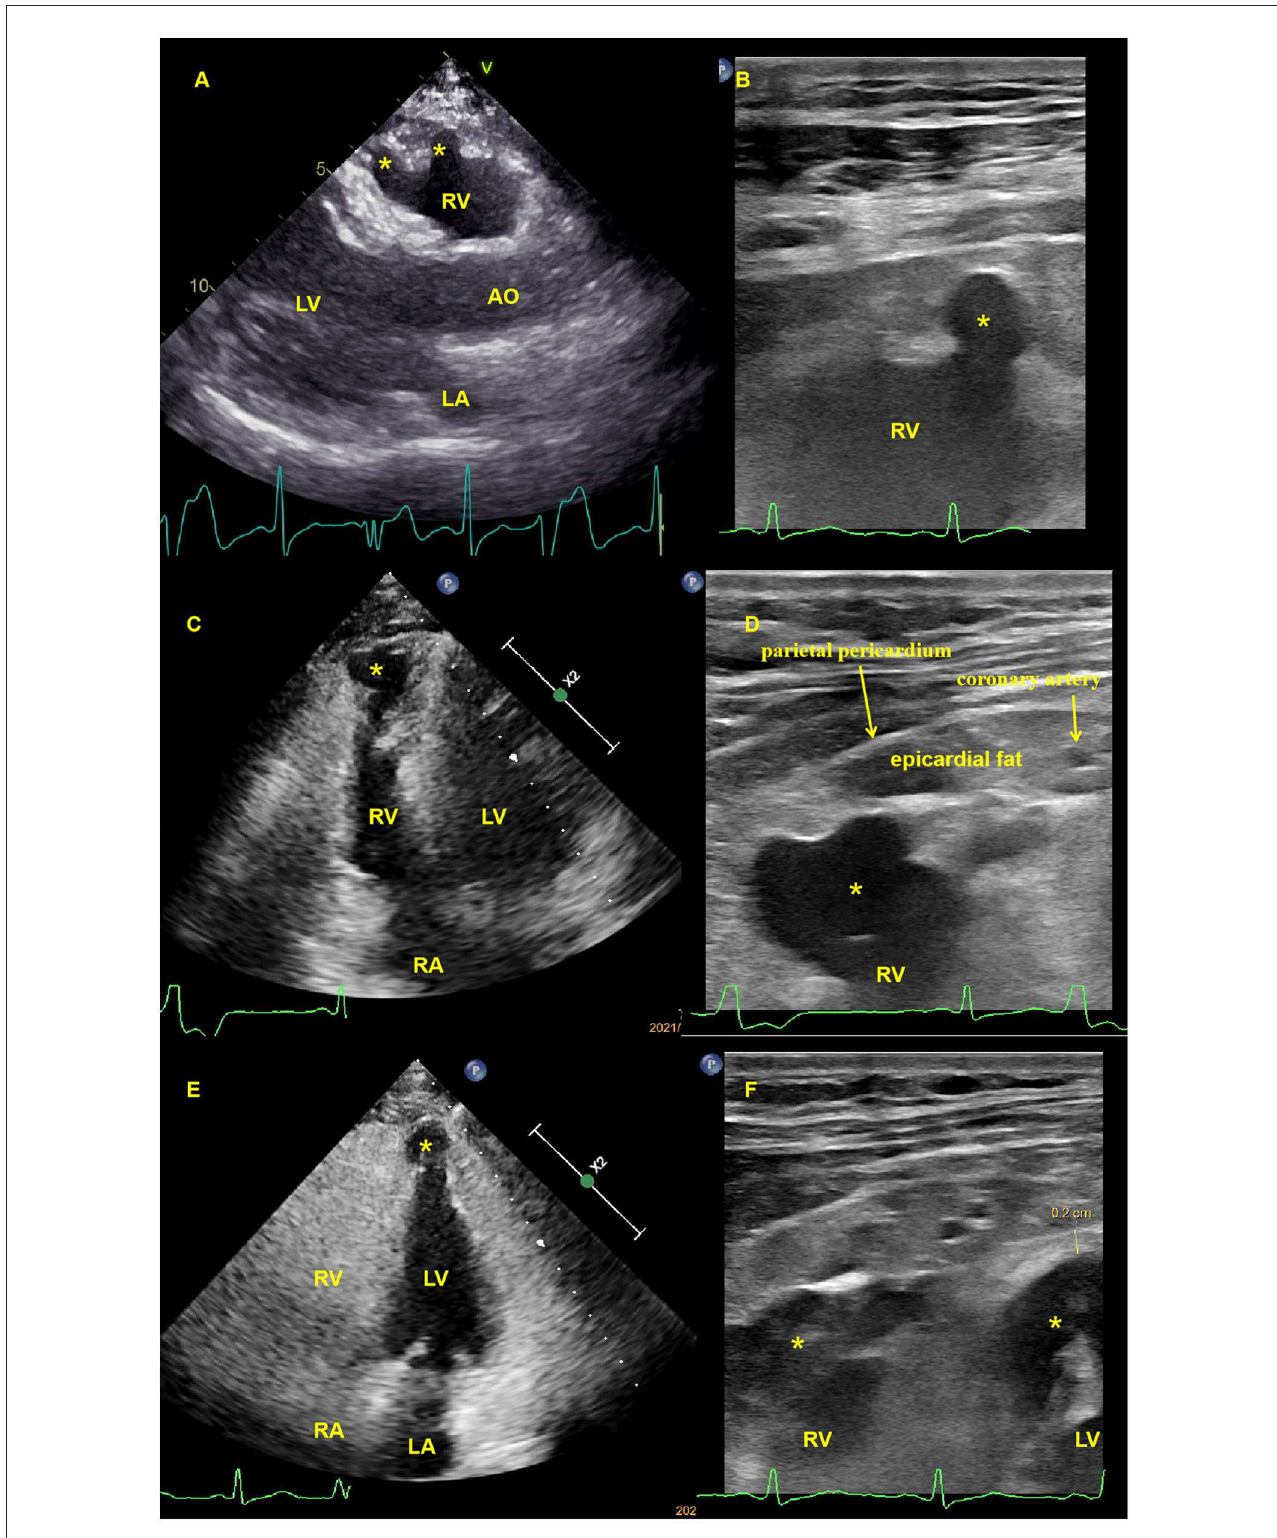
FIGURE2 Transthoracic echocardiography and high-frequency linear ultrasound showed multiple biventricular aneurysms. (A) . Transthoracic echocardiography revealed an anterior right ventricular free wall aneurysm (asterisk) in the parasternal long axis view (see Supplementary Video 1), which had previously been identified using high-frequency linear ultrasound (B, C) . Transthoracic echocardiography revealed a right ventricular apical free wall aneurysm (asterisk) in the apical four-chamber view that was demonstrated by high-frequency linear ultrasound (D) , (see Supplementary Video 2), with a yellow arrow pointing to the apical epicardial coronary artery and a red arrow pointing to the parietal pericardium (E) . Transthoracic echocardiography revealed a left ventricular apical aneurysm (asterisk) in the apical four-chamber view, and high-frequency linear ultrasound revealed both ventricular apical aneurysms (F) , (asterisk) with an apical left ventricular thickness of 2mm. High-frequency ultrasound can also reveal ventricular aneurysmal wall thickness, apical coronary artery, epicardial fat, and parietal pericardial thickness (B, D, F) . AO, aorta; LA, left atrium; LV, left ventricle; RA, right atrium; RV, right